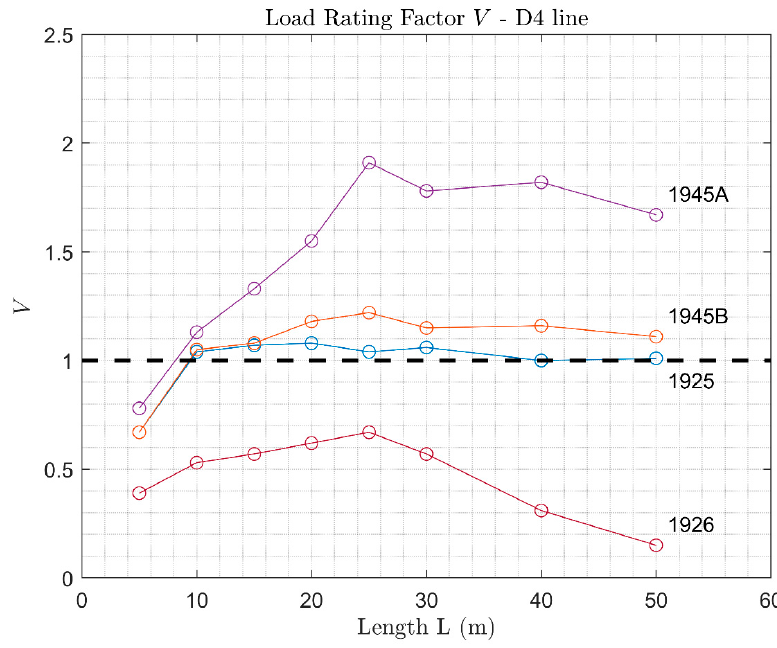
Figure 13. Load Rating Factor of arches verified with D4 loads.